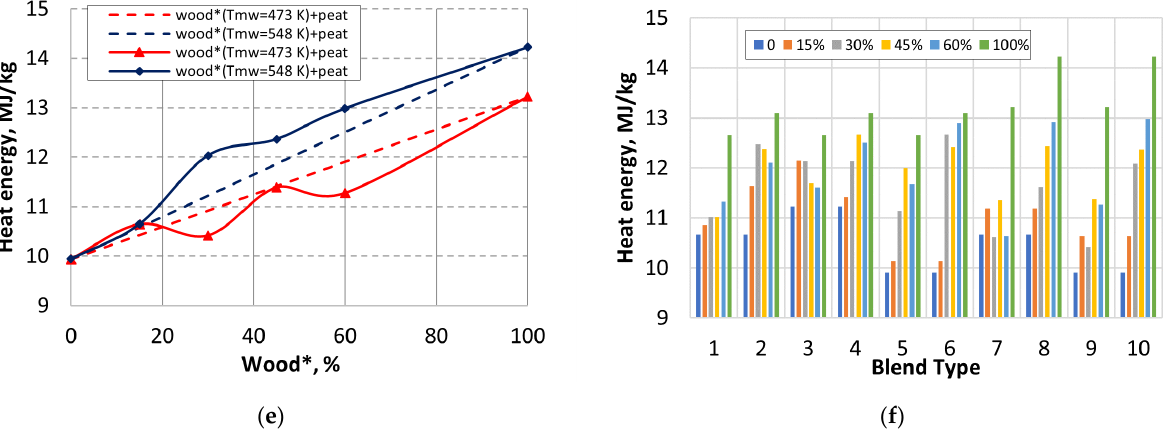
Figure 11. The produced heat energy ( a – e ) and summary of these changes ( f ) for the different types of selectively MW pre-treated blends (for blend composition see Figure 4).